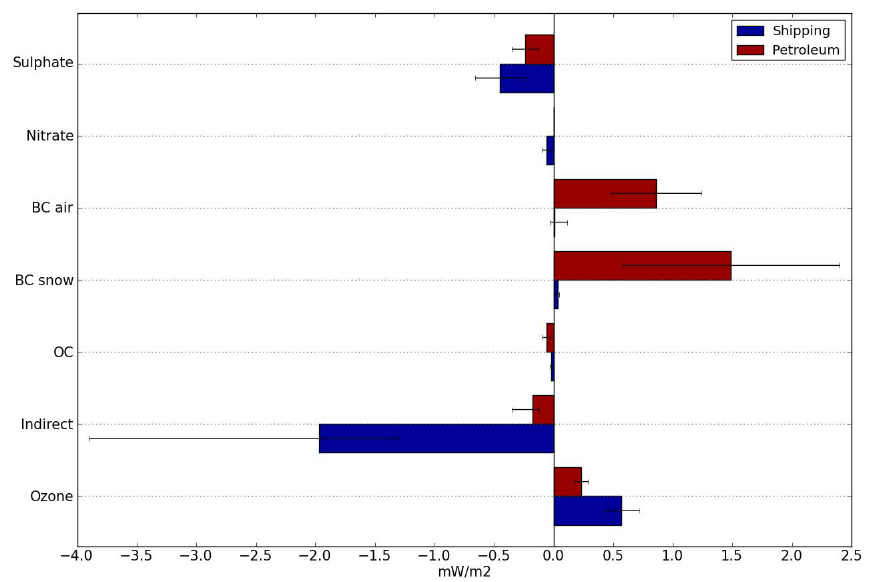
Fig. 7. Global and annual radiative forcing [mWm − 2 ] for the different short lived components from shipping and petroleum emissions. The error-bars imply uncertainties in the estimated